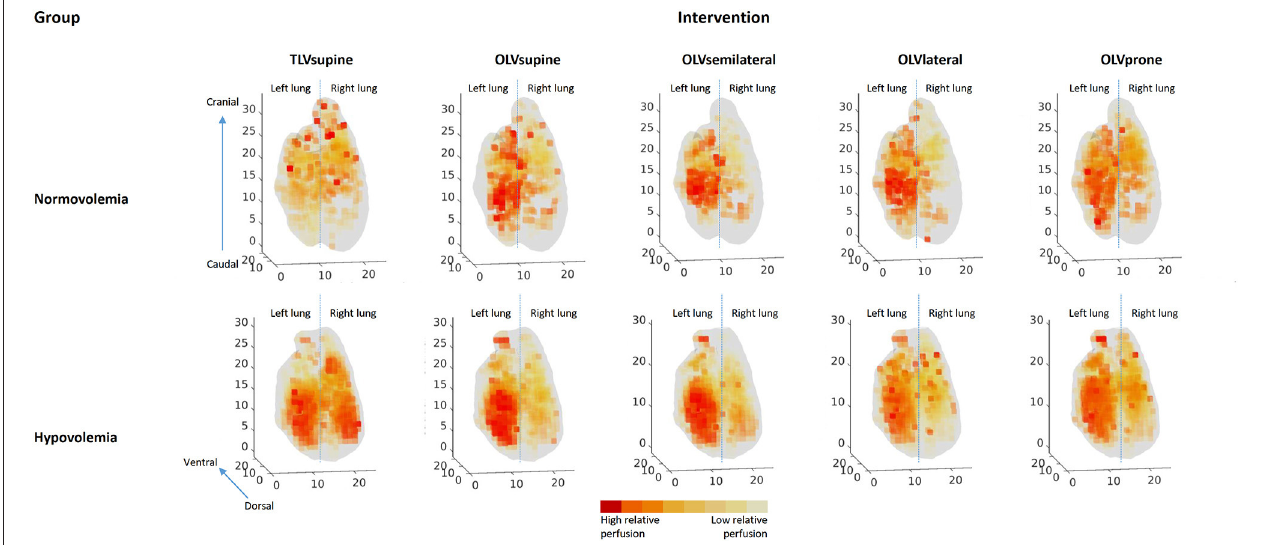
FIGURE 2 | Representative three-dimensional perfusion maps for one animal from each group. Lungs are shown from the dorsal with the left lung on the left side and right lung on the right side. Axes are divided in cm. Lighter colors represent lower relative pulmonary perfusions, while darker colors represent higher relative pulmonary perfusions.